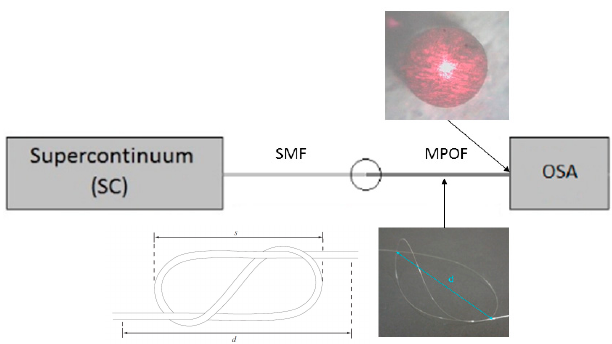
Figure 6. Experimental setup with the sensing head mechanism. SC: Supercontinuum; SMF: single mode fiber; OSA: optical spectrum analyser.